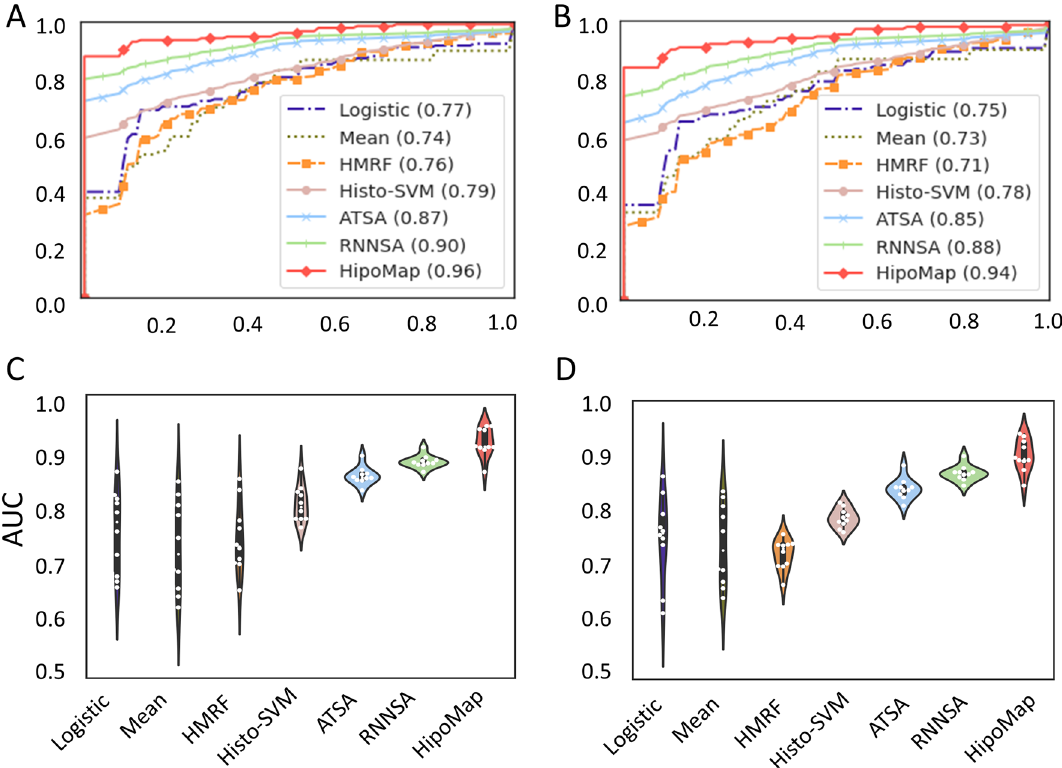
Figure 4. Overall slide-based performance of the benchmark methods and our proposed HipoMap: ( A ) ROC with CAT-Net, ( B ) ROC with GB, ( C ) AUCs with CAT-Net, and ( D ) AUCs with GB.